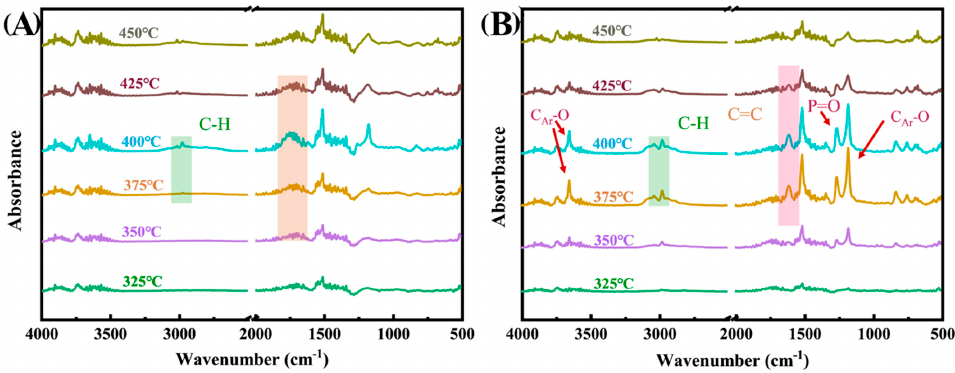
Figure 5. TG-FTIR curves of EP composites: EP ( A ), 3%TAD/1%Zn-PDH/EP ( B